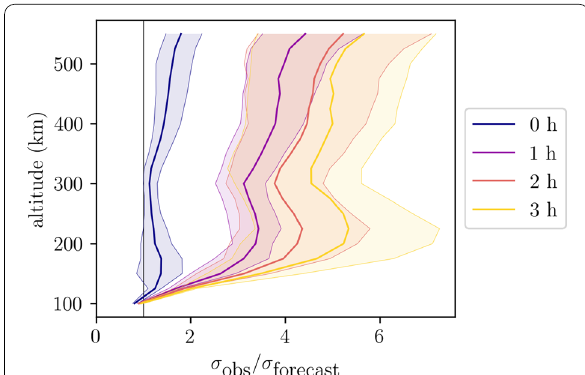
Fig. 9 For the first four analysis steps, the average ratio of the standard deviation of the NRLMSIS 2.0, and the model forecast are plotted for each level of the data grid . A value of one means that both have the same uncertainty. Values greater than one indicate that the observation error is larger than the forecast error. The solid line is the median computed over all layers of the data grid at the corresponding color coded analysis step. The shaded area marks the interval between the 25th and 75th percentile